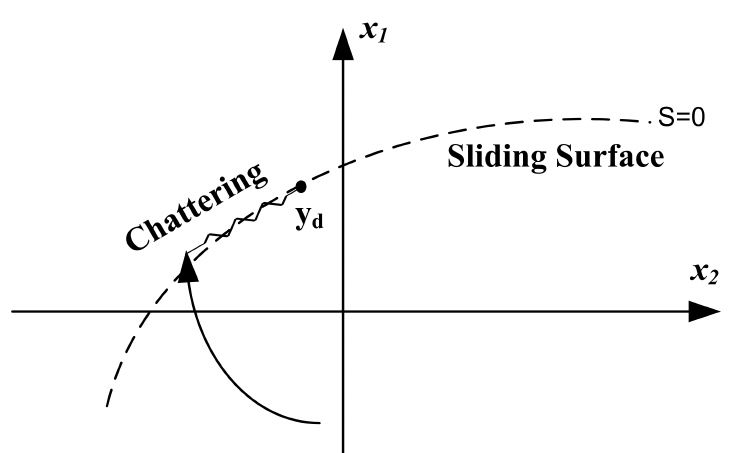
Figure 3. Chattering phenomena occurs during sliding mode and is practically unwanted in control